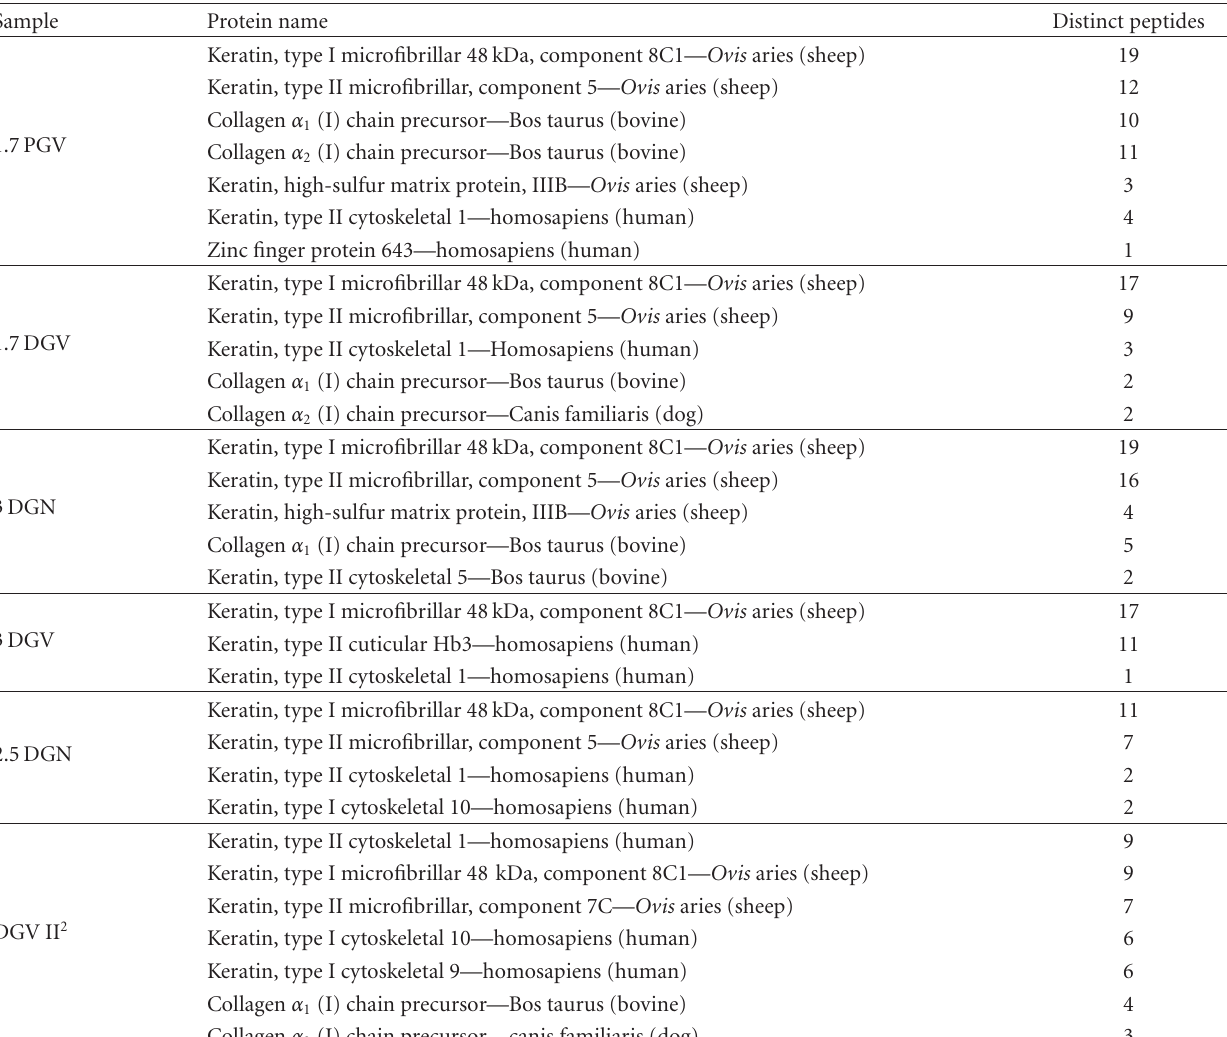
Table 2: List of identified saiga proteins. Sample 1.7PGV, 1.7DGV, 3 DGN, 3DGV, 2.5DGN, DGV II 2 digested by trypsin.